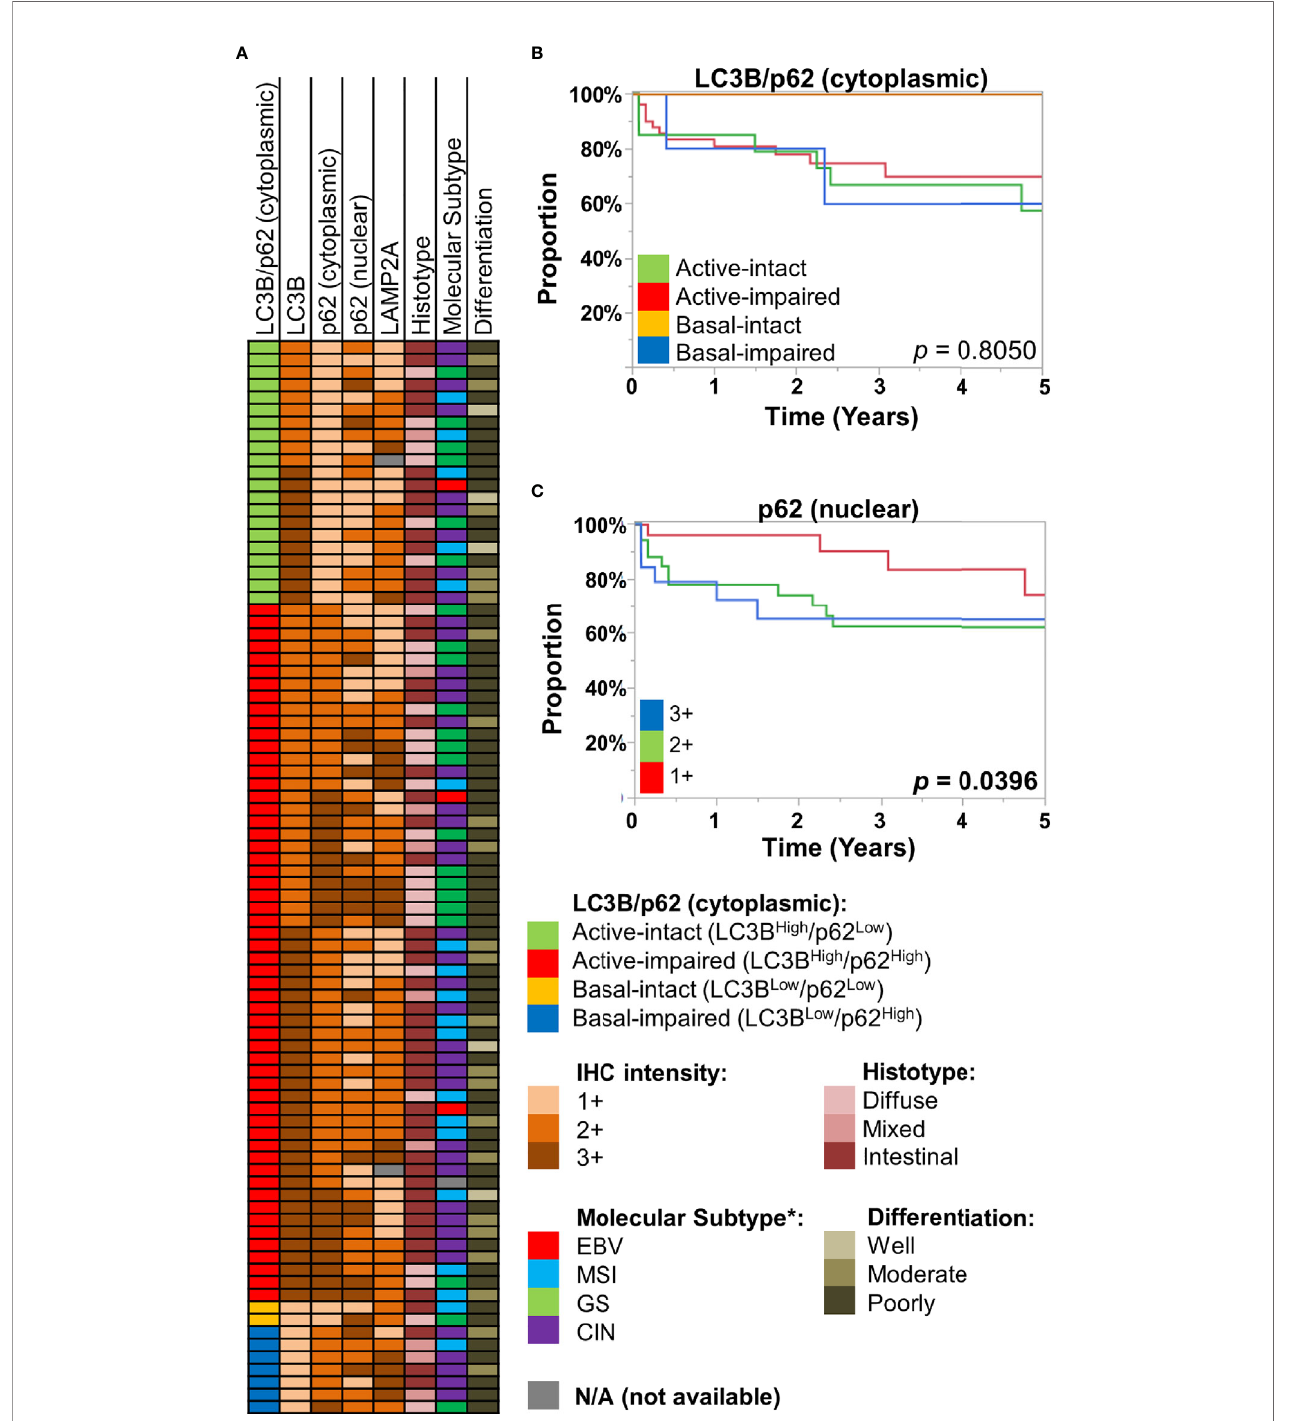
FIGURE 2 | (A) Case information for the 86 gastric/gastro-esophageal junction (GEJ) adenocarcinoma cases, displaying their LC3B/p62 (cytoplasmic) staining patterns, along with immunohistochemical (IHC) intensity for LC3B, p62 (cytoplasmic, nuclear), and LAMP2A for each case. Also displayed are their respective histotype, approximated TCGA molecular subtype (see Methods ), and tumor differentiation. (B, C) Kaplan-Meier curves, showing overall survival of the St. Michael ’ s gastric/GEJ adenocarcinoma cohort, divided by (B) macroautophagic subtypes (LC3B/cytoplasmic p62), and (C) nuclear p62